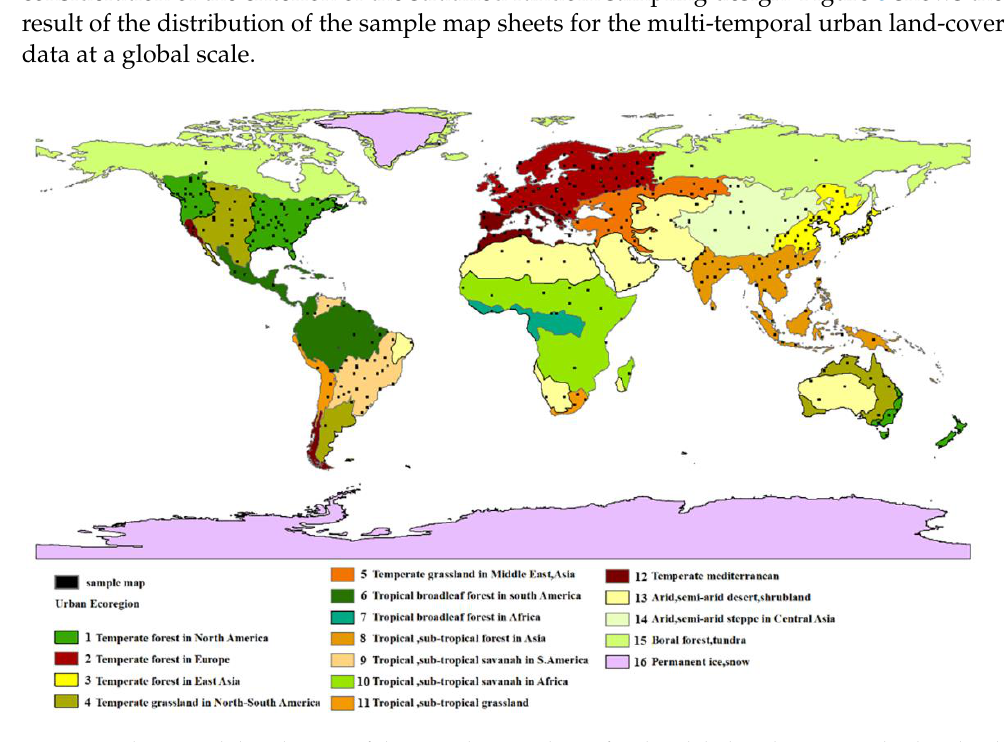
Figure 8. The spatial distribution of the sample map sheets for the global multi-temporal urban land- cover data. The black squares represent the 1° × 1° PSUs. The panels in different colors represent the different urban ecological regions. The map of global urban land cover shows 16 geographic strata.